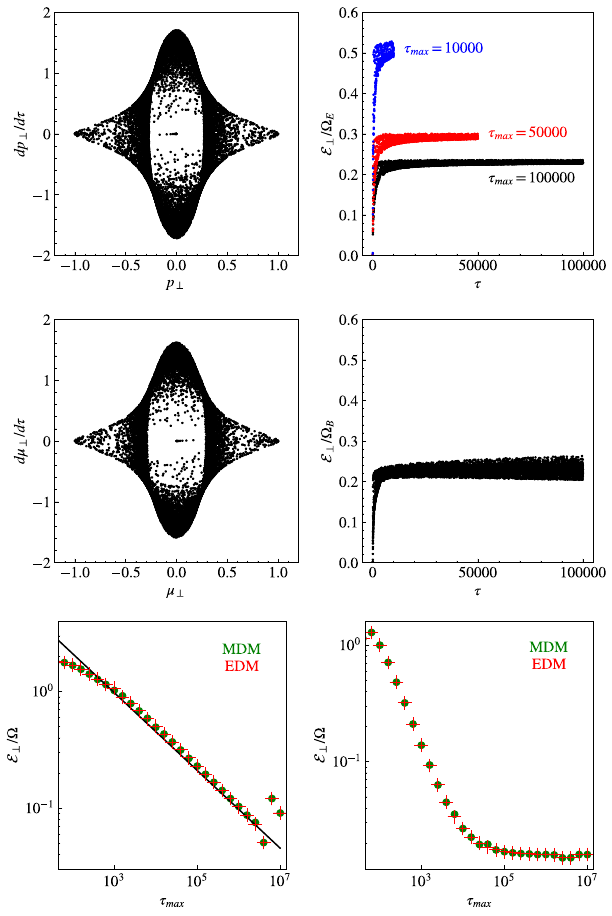
FIG. 25. Electric dipole moment phase space orthogonal to the local field direction, ð p ⊥ , dp ⊥ =d τ Þ (top left), and the adiabatic invariant A as a function of the number of oscillations inv (top right). The right panel presents data for three different values of τ . The middle two panels present analogous simulation max results for the case of the magnetic dipole moment. At the beginning of each simulation, large oscillations of p ⊥ or μ ⊥ are seen, which later on converge onto an ellipse. The width of this ellipse in the direction of p ⊥ , or μ ⊥ , becomes smaller the larger τ is. Recalling Eq. (A15), τ can be expressed as max max τ ¼ T = ð 2 π Þðj p j E =I Þ 1 = 2 , and, therefore, the width of the 0 i max ramp ellipse in the direction of p ⊥ becomes smaller the more adiabatically the field changes (larger T ) and the higher ramp the final field is (higher E 0 ). This is demonstrated in the bottom panel by the dependence of A on τ , both for a linear (left) inv max and for a Gaussian ramp